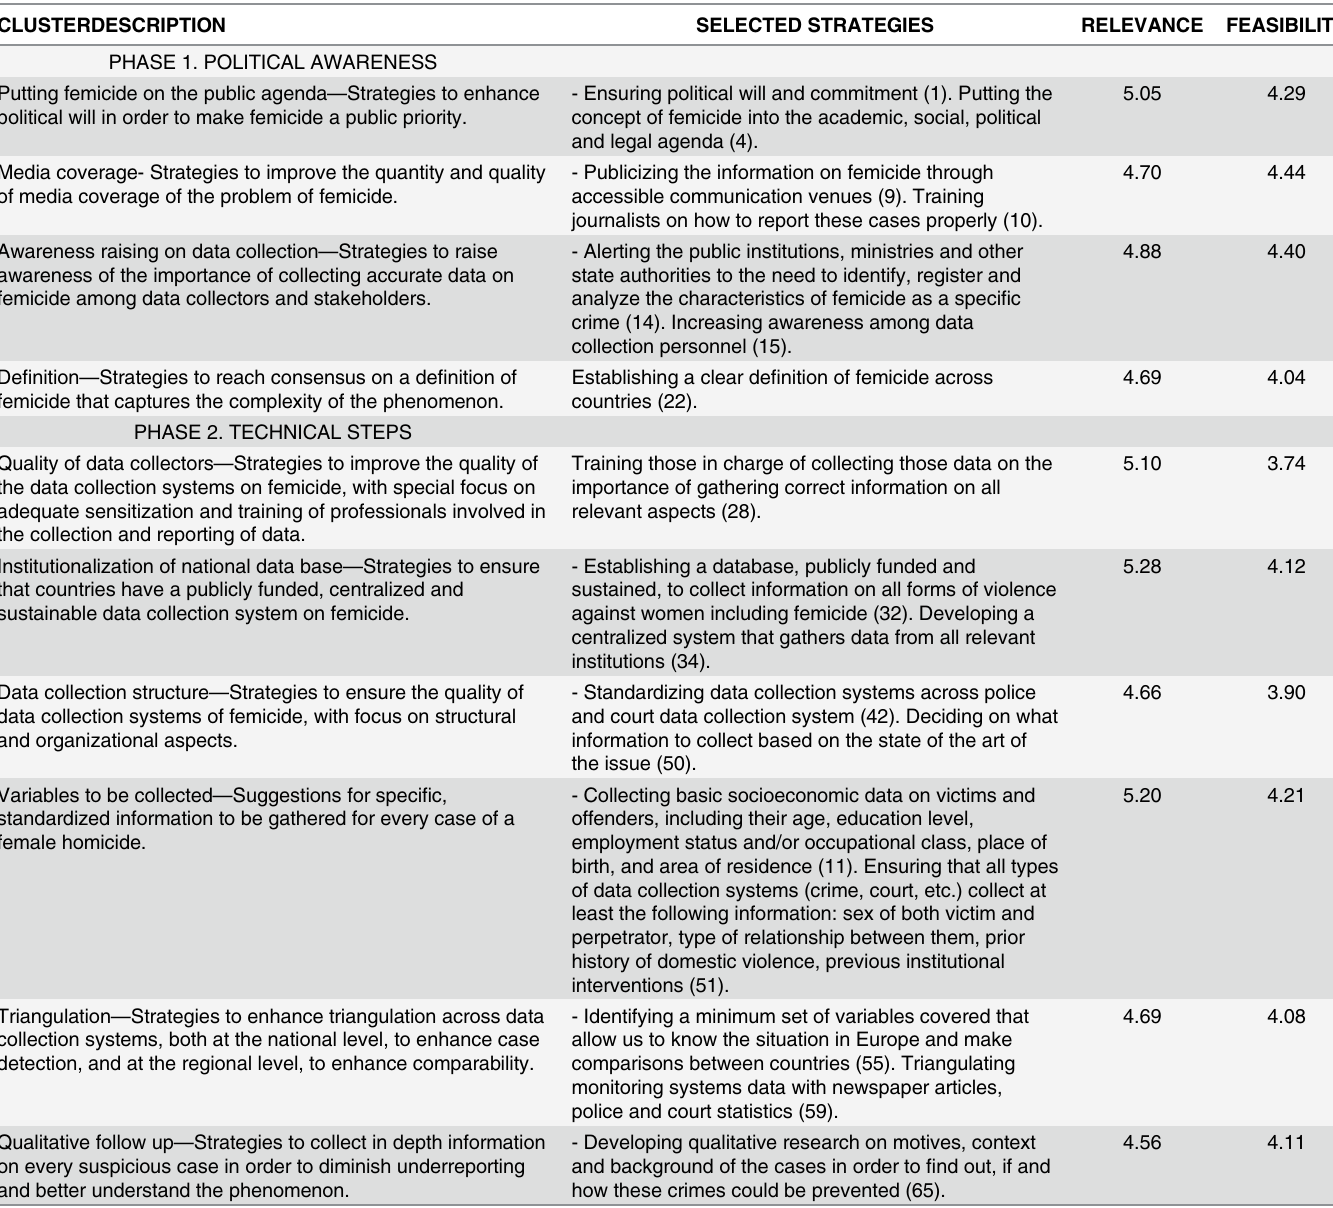
Table 2. Overview of the content of the clusters, selected strategies and average ratings of clusters